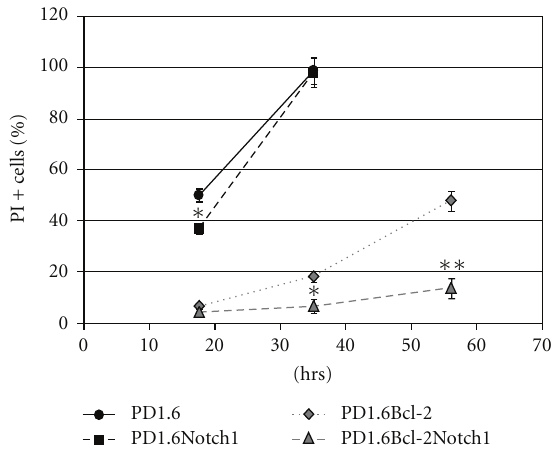
Figure 2: PD1.6 cells overexpressing both ICN-Notch1 and Bcl-2 become resistant to dexamethasone (Dex)-induced apoptosis. The cells were exposed to 100 nM Dex for the indicated time periods, followed by analysis of propidium iodide (PI) positive cells on flow cytometry. Untreated cells were used as control. ∗ P < 0 . 04 ∗∗ P < 0 .